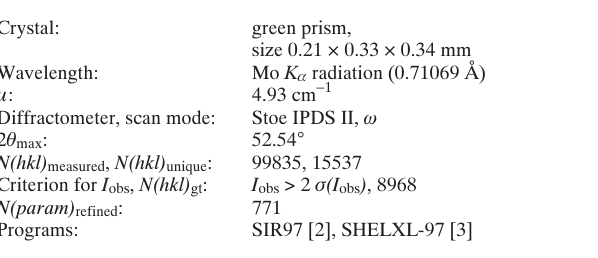
Table 1. Datacollection and handling.